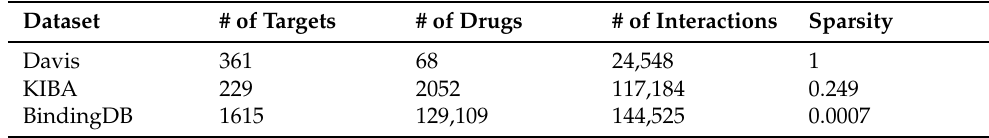
Table 1. The detailed statistics of the